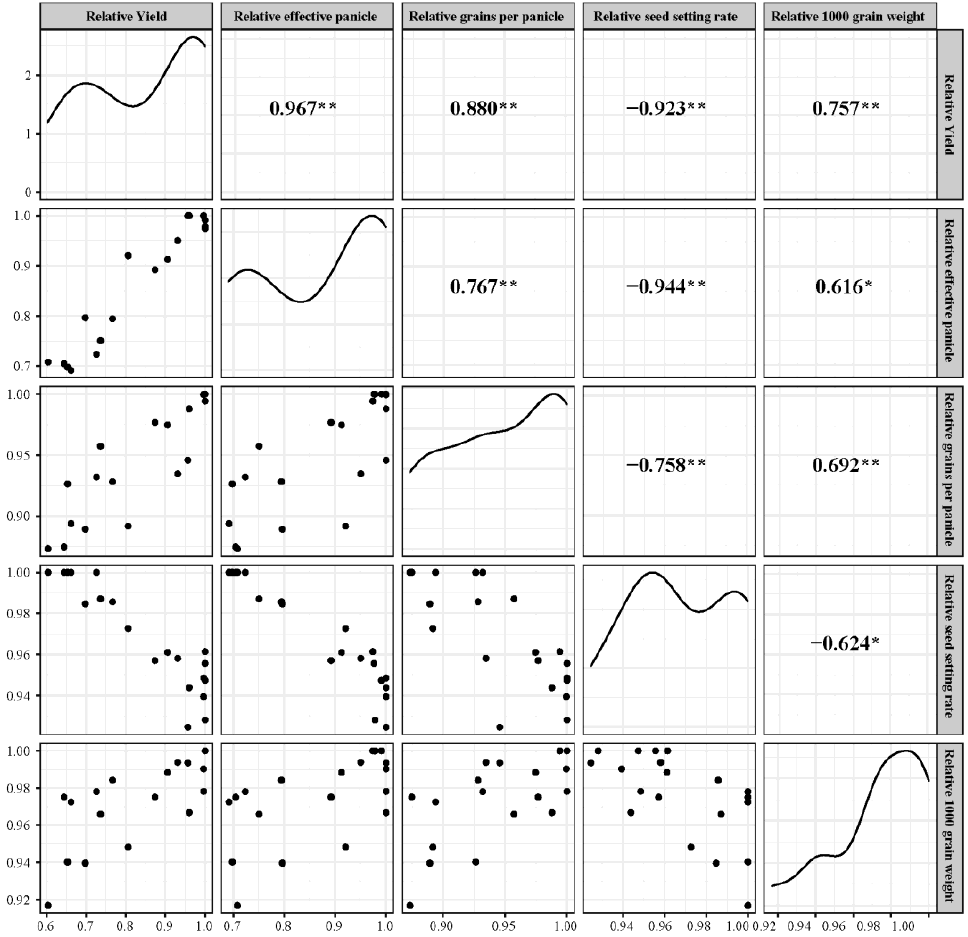
Figure 10. Correlation between the relative yield and relative yield components of indica hybrid rice. ** indicates significance at the 0.01 level; * indicates significance at the 0.05 level.